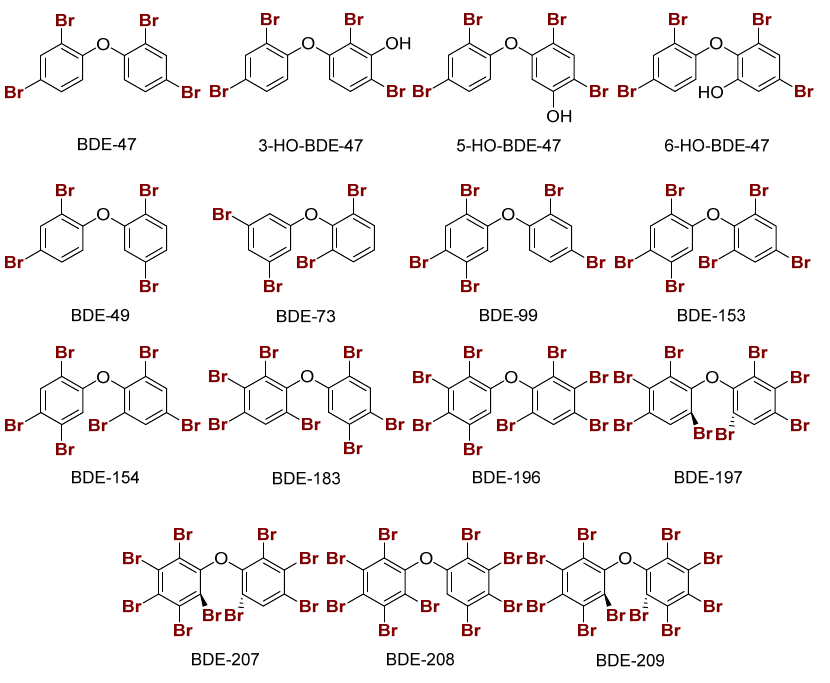
Figure 6. Sample structures of PBDEs and the hydroxylated metabolites of